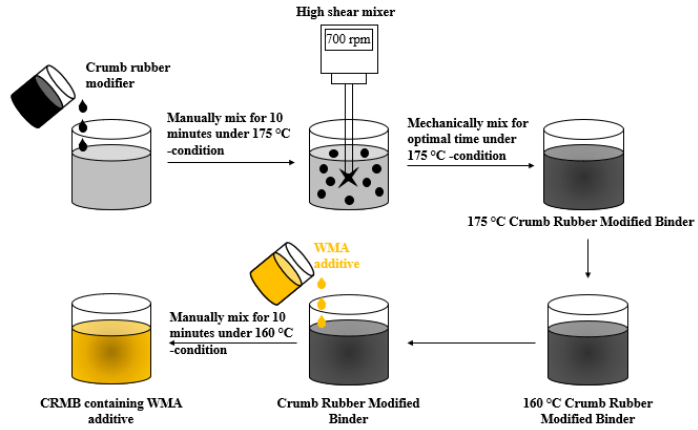
Figure 3. Mixing procedure for preparing CR-modified binders in this